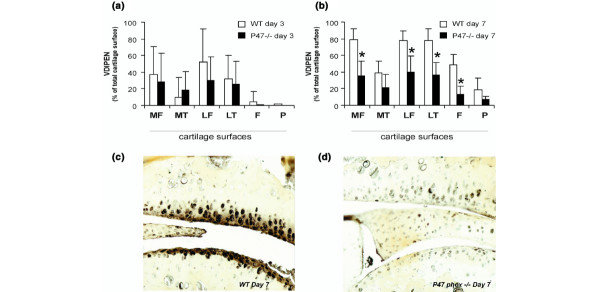
VDIPEN expression inday 3 (a) and day 7 (b) inflamed knee joints. Positive VDIPEN staining was determined in various cartilage layers (LF, lateral femur; LT, lateral tibia; MF, medial femur; MT, medial tibia; P, patella) at an original magnification of ×100 by using automated image analysis and was expressed as a percentage of the total cartilage surface. VDIPEN staining was significantly lower at day 7 in lateral and medial femur and lateral tibia of p47phox-/- mice (d) than in wild-type mice on day 7 (c) Data are means ± SD for eight mice.